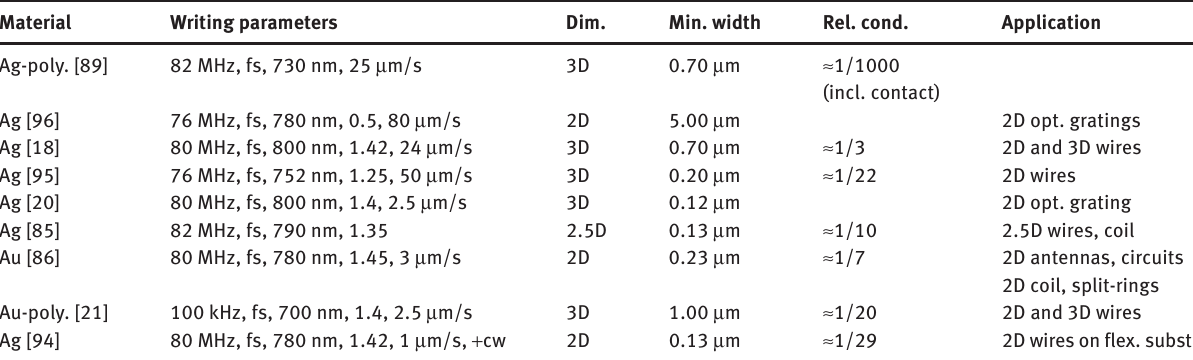
Table 2: Results of some significant contributions to the field sorted by date.